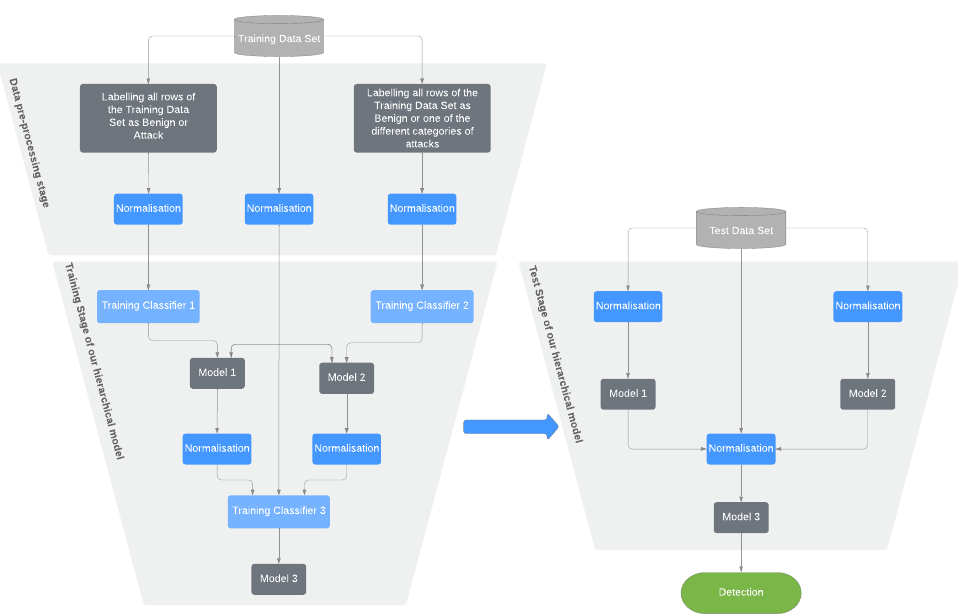
Figure 1. General structure of Rules and Decision Tree-based Intrusion Detection System (RDTIDS) system.